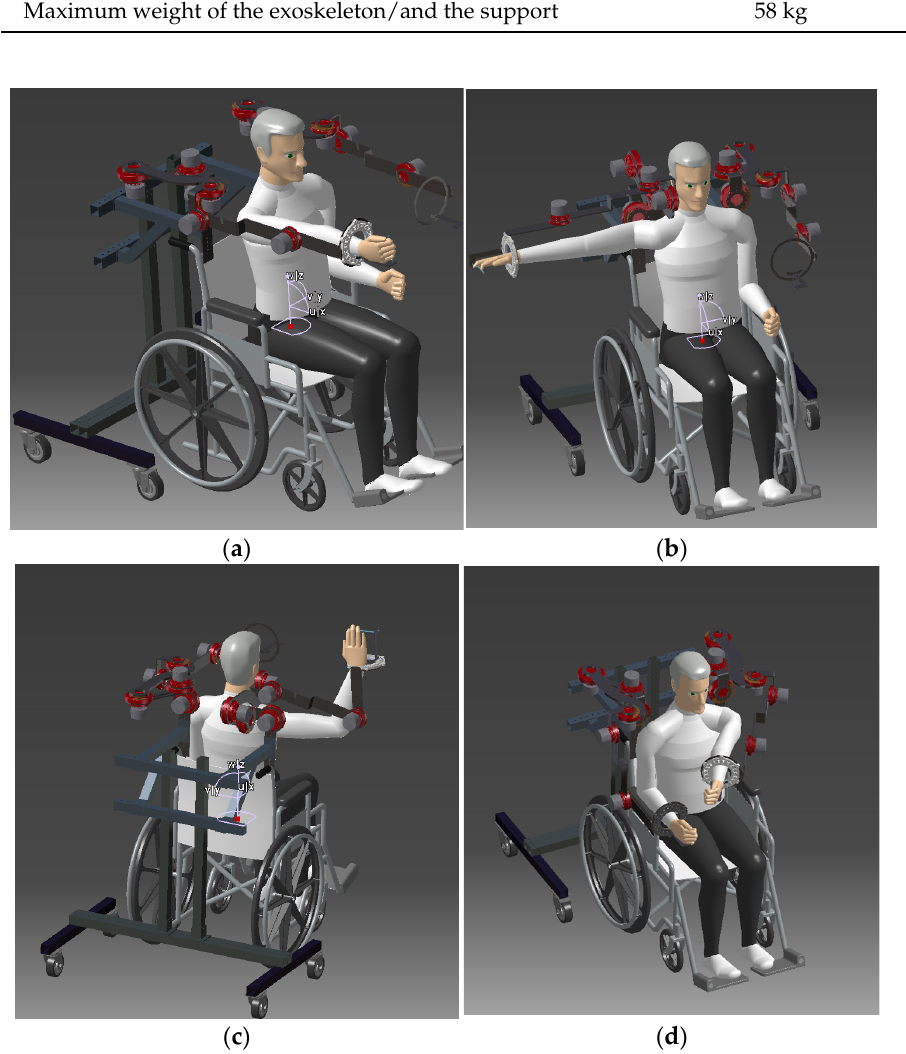
Figure 3. The main possible movements of the CardioVR-ReTone robotic exoskeleton. The main possible movements of the CardioVR-ReTone robotic exoskeleton: ( a ) elevation and flexion of the shoulder and arm; ( b ) elevation and extension of the shoulder and arm; ( c ) elbow flexion/extension; ( d ) adduction of the arm and